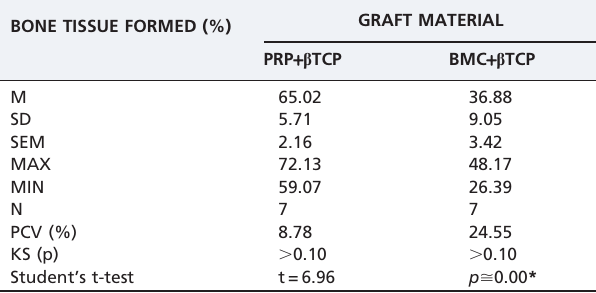
Table 3 - Bone tissue formed by area (%) after consolidation of defects filled with PRP + b TCP or BMC + b TCP, as measured using histomorphometry. Normality assessment using Pearson’s Coefficient of Variation (PCV) and the Kolmogorov-Smirnov test (KS). Comparison using Student’s t-test ( a = 0.05